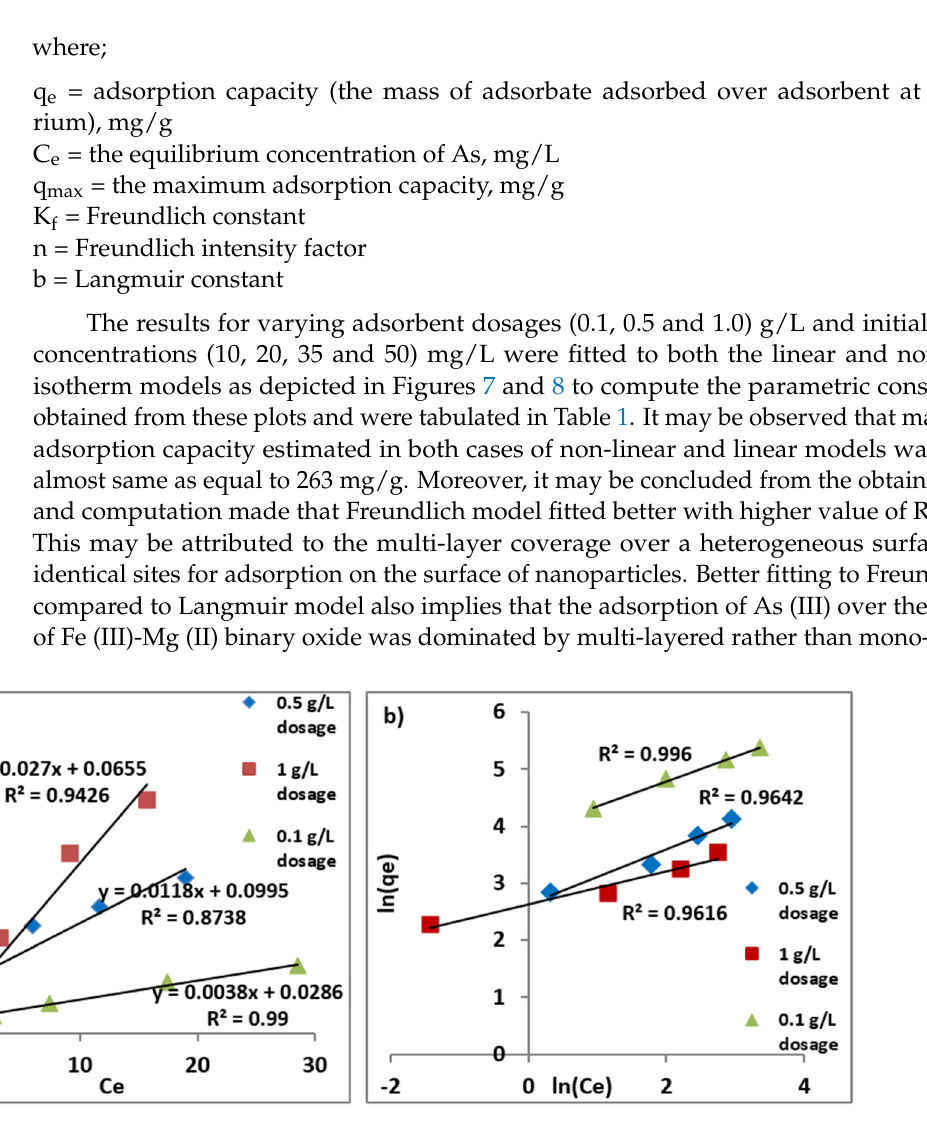
Figure 7. Linear models of ( a ) Langmuir adsorption isotherm at 0.1, 0.5 and 1.0 g/L adsorbent dosages, ( b ) Freundlich adsorption isotherm at 0.1, 0.5 and 1.0 g/L adsorbent dosages. Table 1. Parametric values obtained from isotherm plots for As (III) adsorption experimental runs at initial pH 6 and room